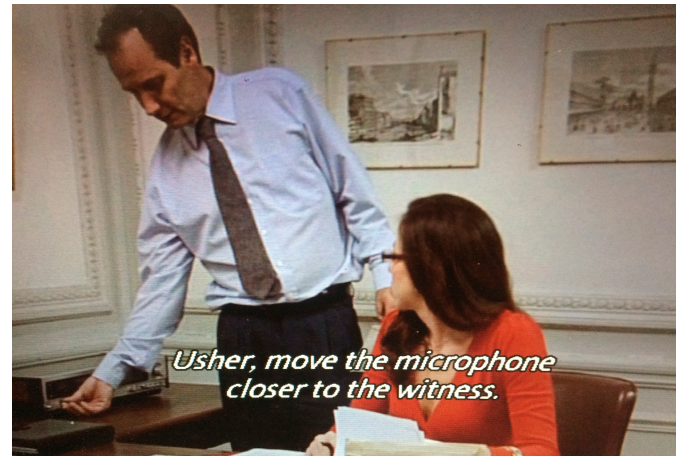
Figure 2. Radio Broadcast of Katz Testimony.